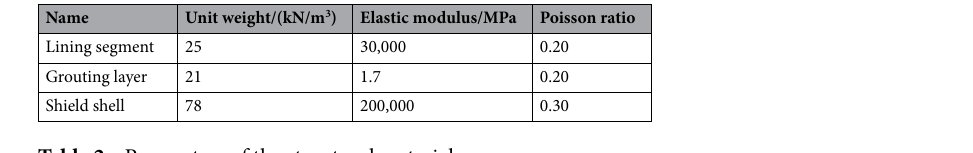
Table 2. Parameters of the structural